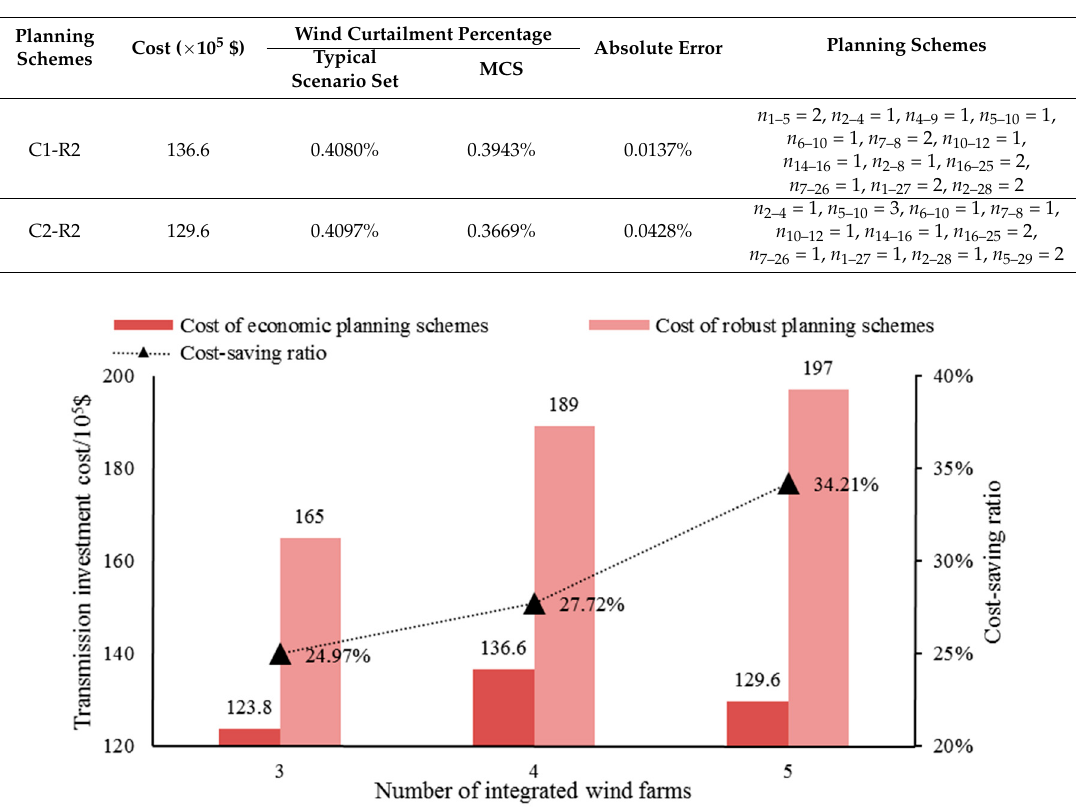
Figure 9. The comparison of investment cost and cost saving ratio under different TNEP cases.